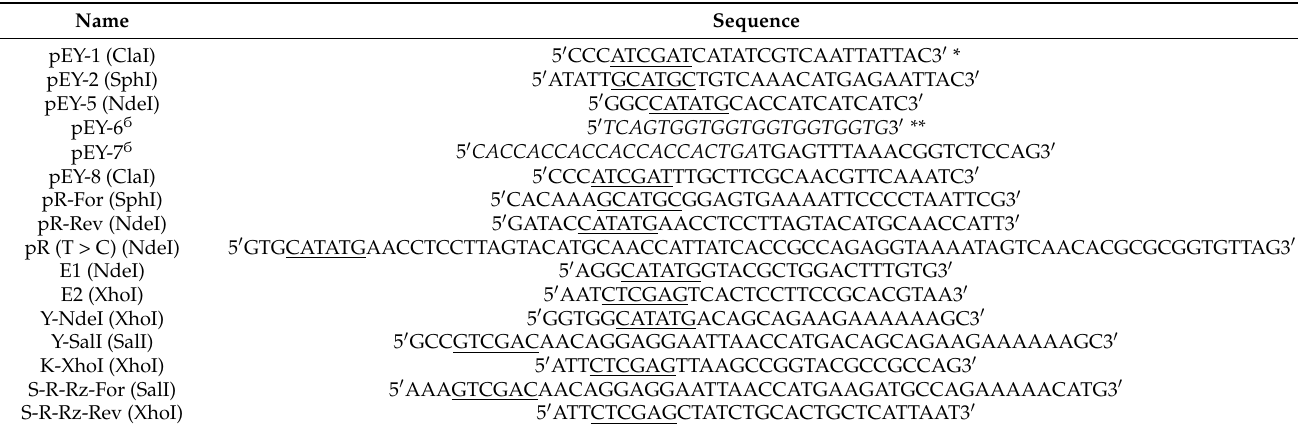
Table 2. Primers used in this